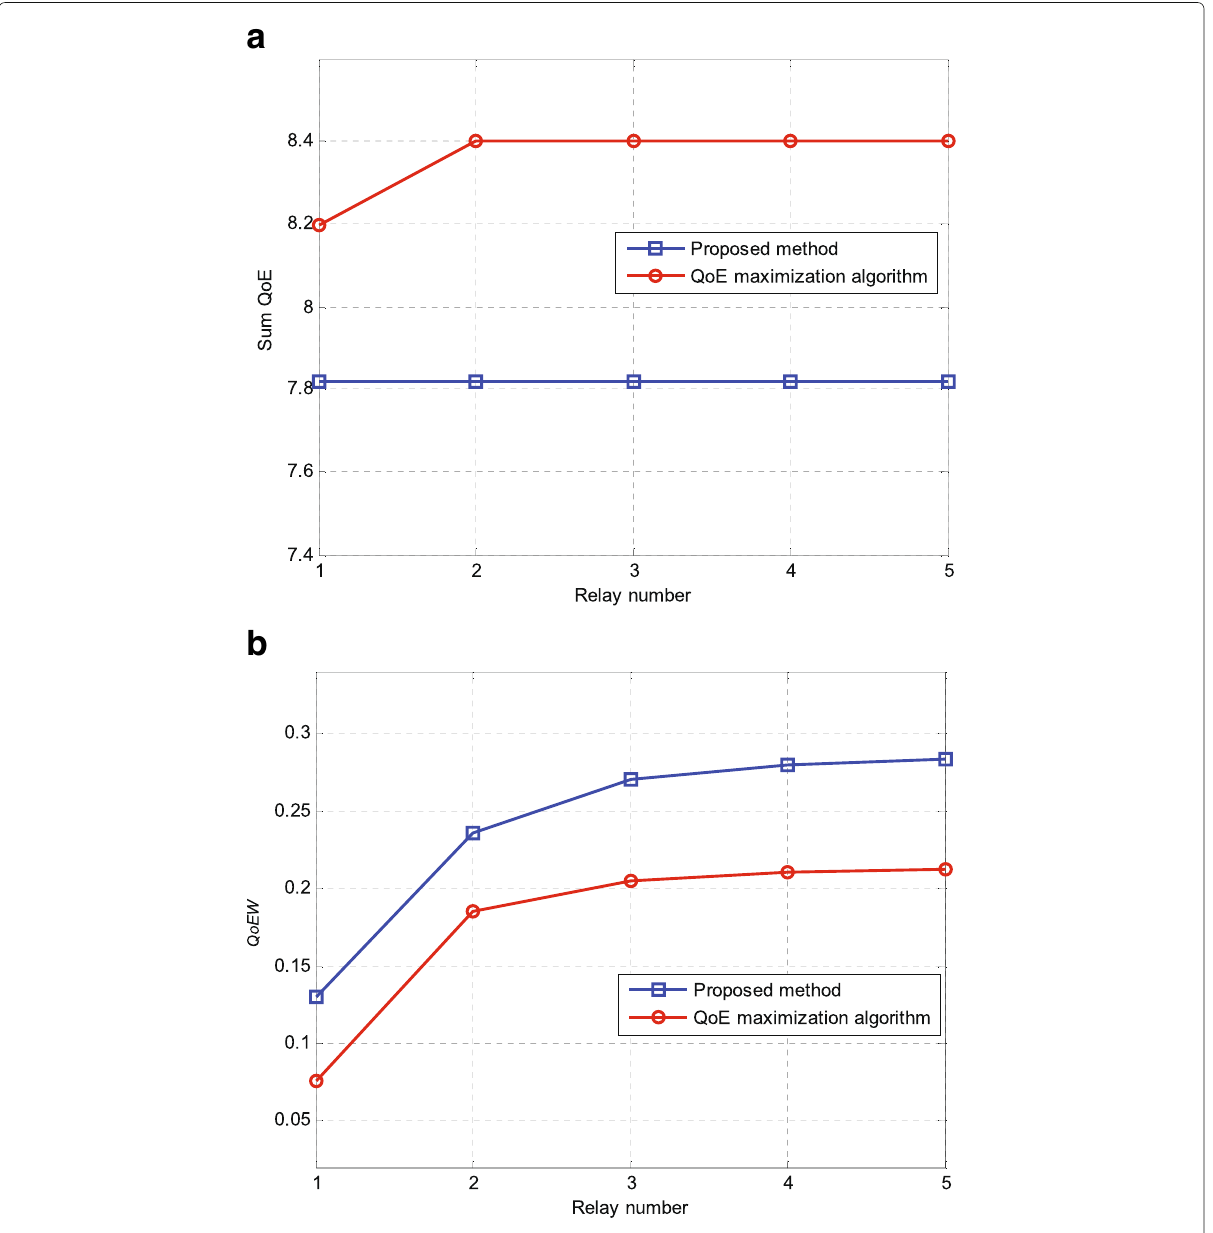
Fig. 4 Sum QoE and QoEW versus relay number. a Effect of relay number on sum QoE. b Effect of relay number on